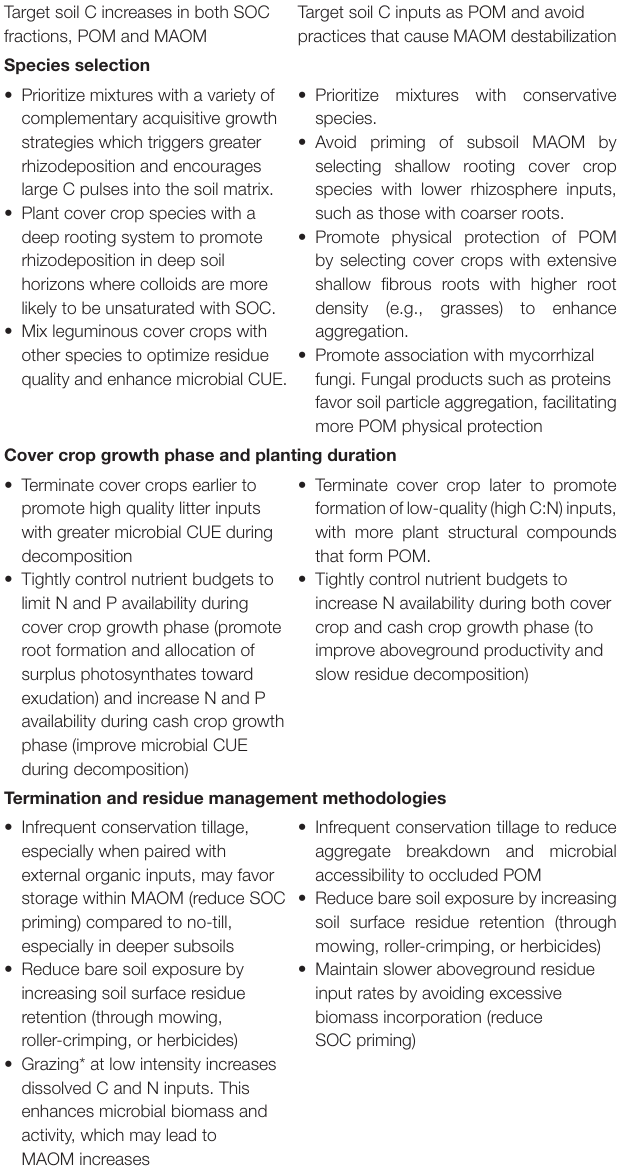
TABLE 1 | Summary table of considerations for cover crop management to promote soil organic carbon sequestration. Suggested considerations of cover crop management strategies Before soil MAOM saturation After soil MAOM saturation Main objective: Main objective: Target soil C increases in both SOC Target soil C inputs as POM and avoid fractions, POM and MAOM practices that cause MAOM destabilization Species